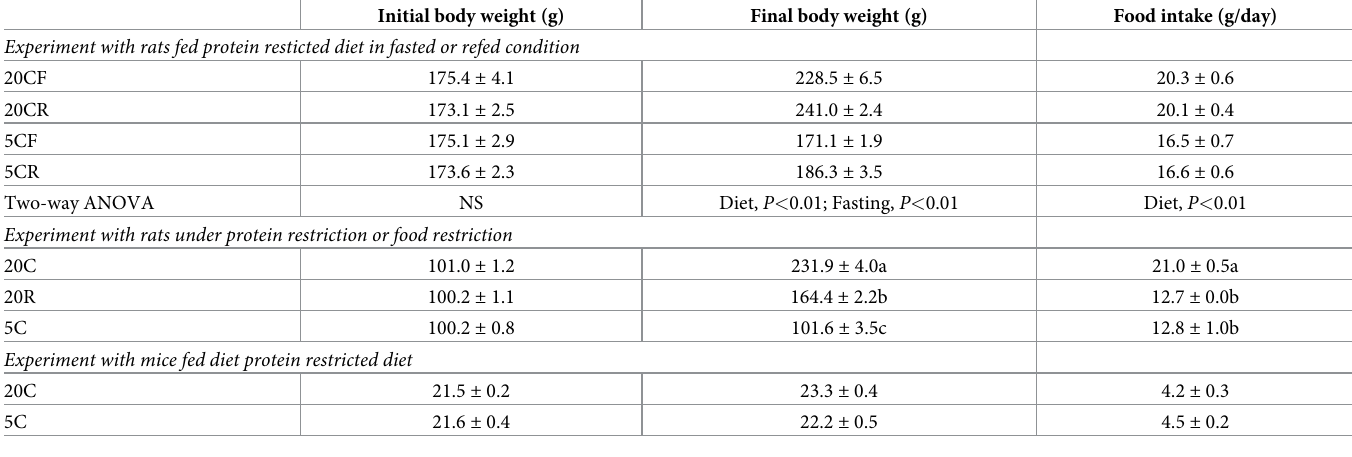
Table 4. Body weight and food intake of rats and